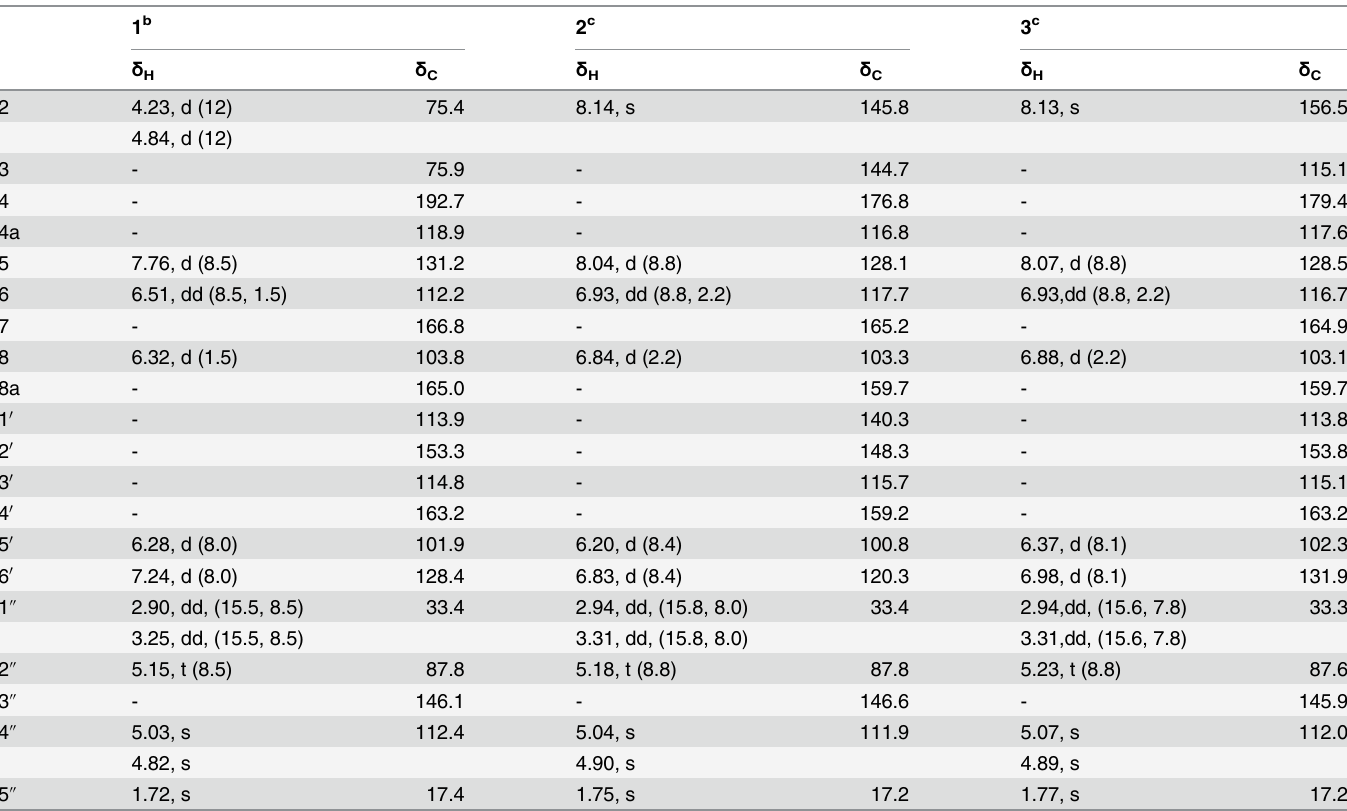
Table 1. 1 H, 13 C NMR (CD3OD) data of compound 1, 2, 3.